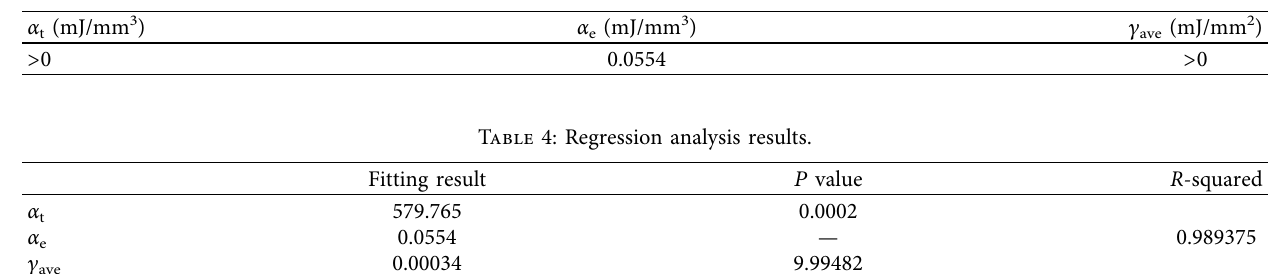
Table 3: Boundary conditions constrained by physical significance.